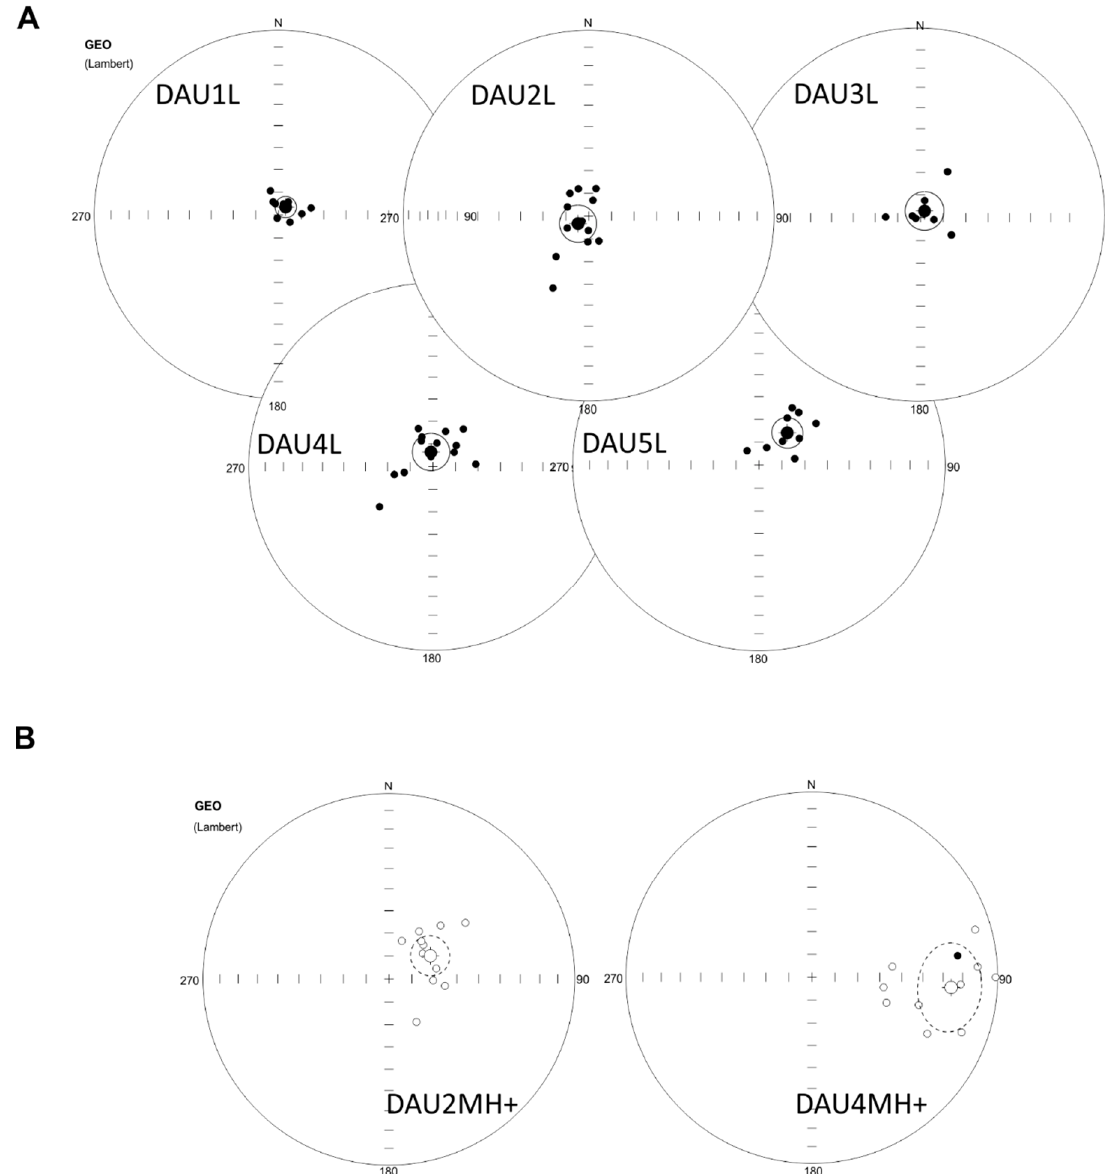
Figure 11. ( A ) Low temperature NRM components, ( B ) Medium-high temperature NRM components on equal area projections representing metadolerites sites from SW Oscar II Land. All of the components presented passed statistical criteria— κ >10, α 95 < 17° and were accepted for further interpretation. Open and full symbols correspond to upper and lower hemisphere respectively. Site mean directions with their radiuses of 95% confidence circles are presented. Specification of palaeomagnetic parameters is summarized in Table 2.